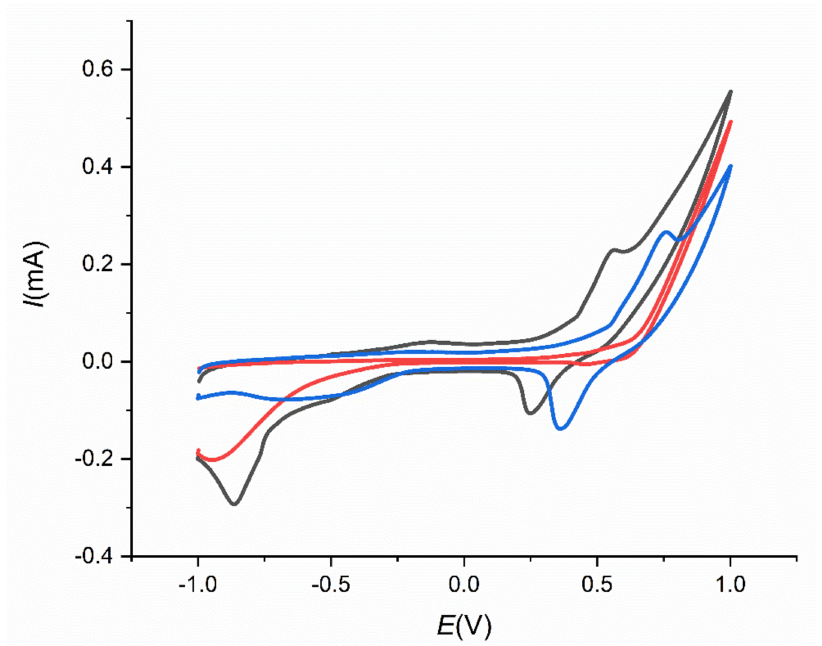
Figure 15. Cyclic voltammograms for 10 µ M insulin in 0.1 M NaOH and PBS on SPCE/MWCNT/ NiO1.5 with various temperature of the analyst’s solution, t 1 = 8 ◦ C (blue line), t 2 = 20 ◦ C (black line), and t 3 = 45 ◦ C (red